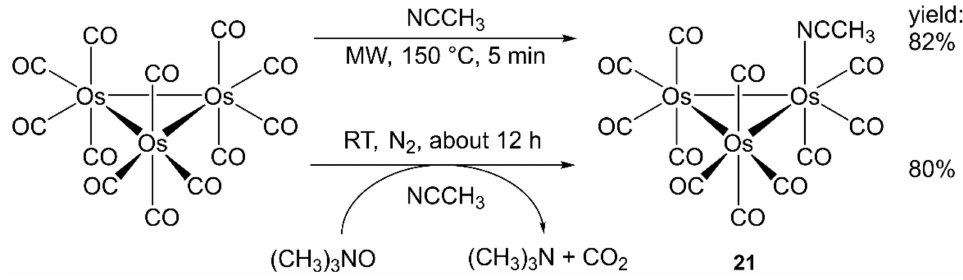
Figure 7. Scheme of the reaction to obtain the activated [Os 3 (CO) 11 (NCCH 3 )]